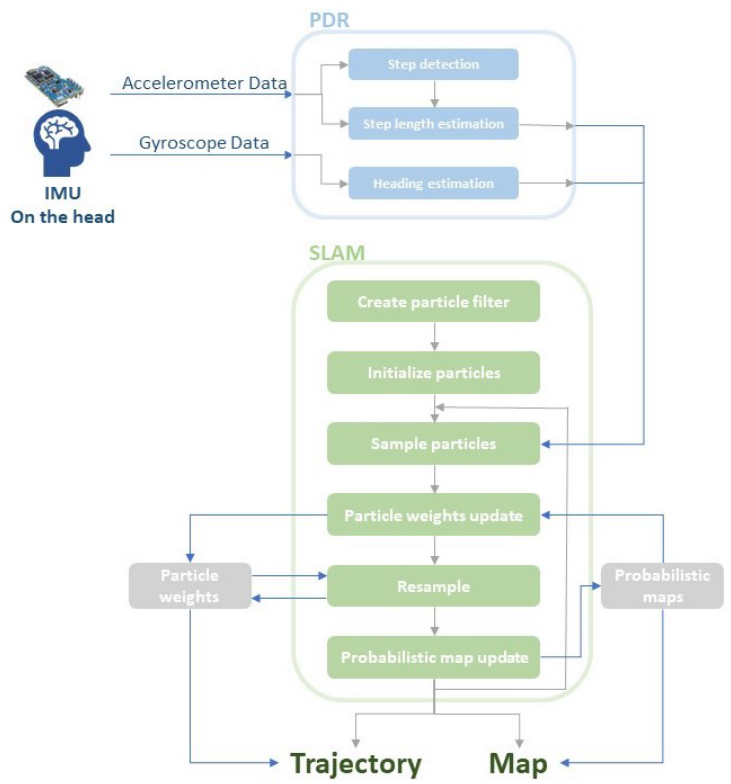
Figure 1. Overview of the HeadSLAM method. The Simultaneous Localisation And Mapping (SLAM) step is performed after the Pedestrian Dead Reckoning (PDR) in order to create a map based on the data collected from head-mounted inertial measurement units. The grey arrows show the sequence of the flowchart. The dark blue arrows represents the data or the variables’ usage or